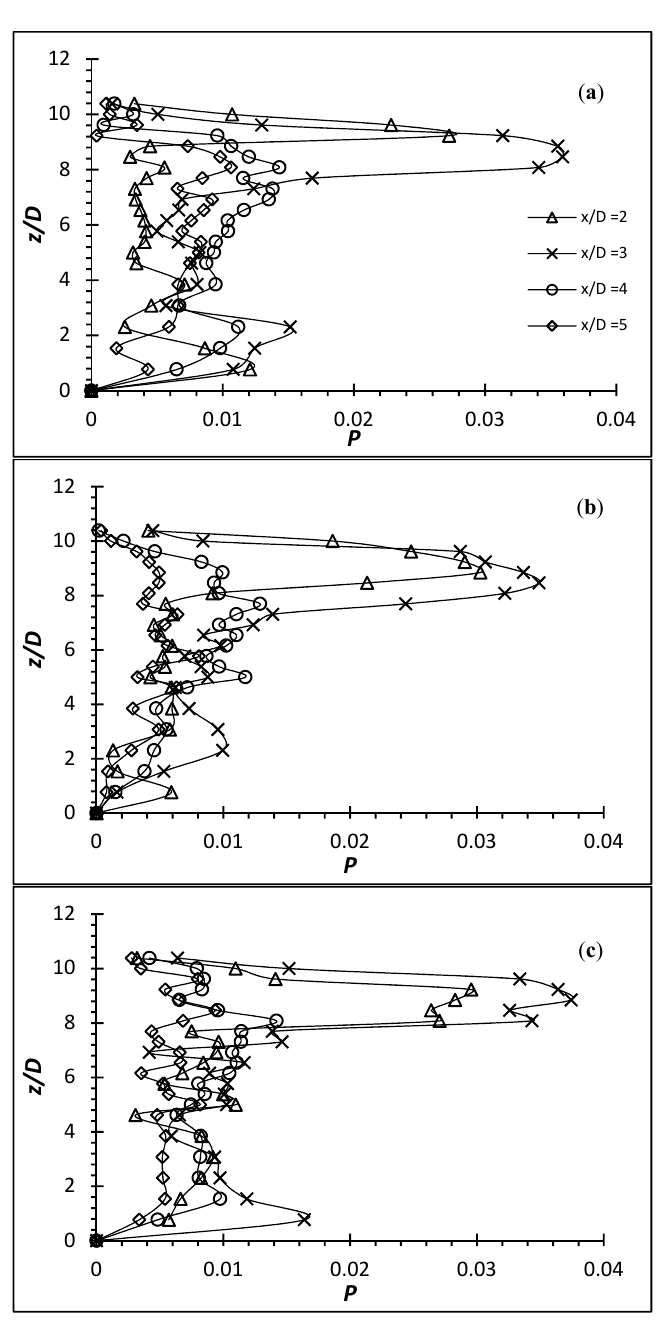
∂ U i for rigid cylinder of AR = 10 at ( a ) Re = 4000; ( b ) Re = 6000; ( c ) u (cid:48) for rigid cylinder of AR = 10 at ( a ) Re = 4000; ( b ) Re = 6000; i j ∂ x j (cid:3105)(cid:3051) (cid:3285)